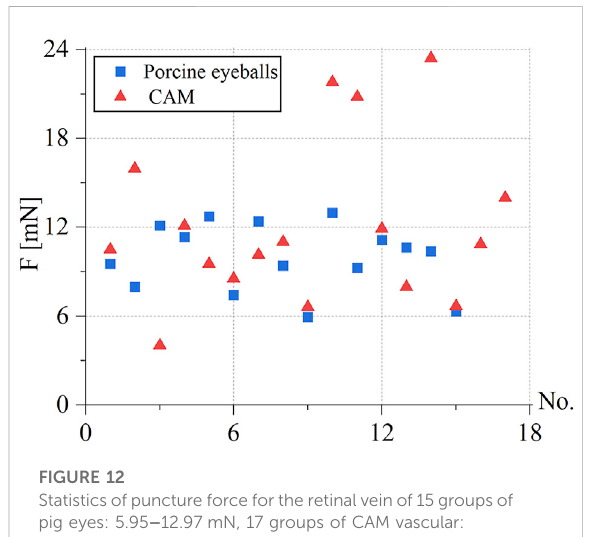
FIGURE 12 Statistics of puncture force for the retinal vein of 15 groups of pig eyes: 5.95 – 12.97 mN, 17 groups of CAM vascular: 4.02 – 23.4